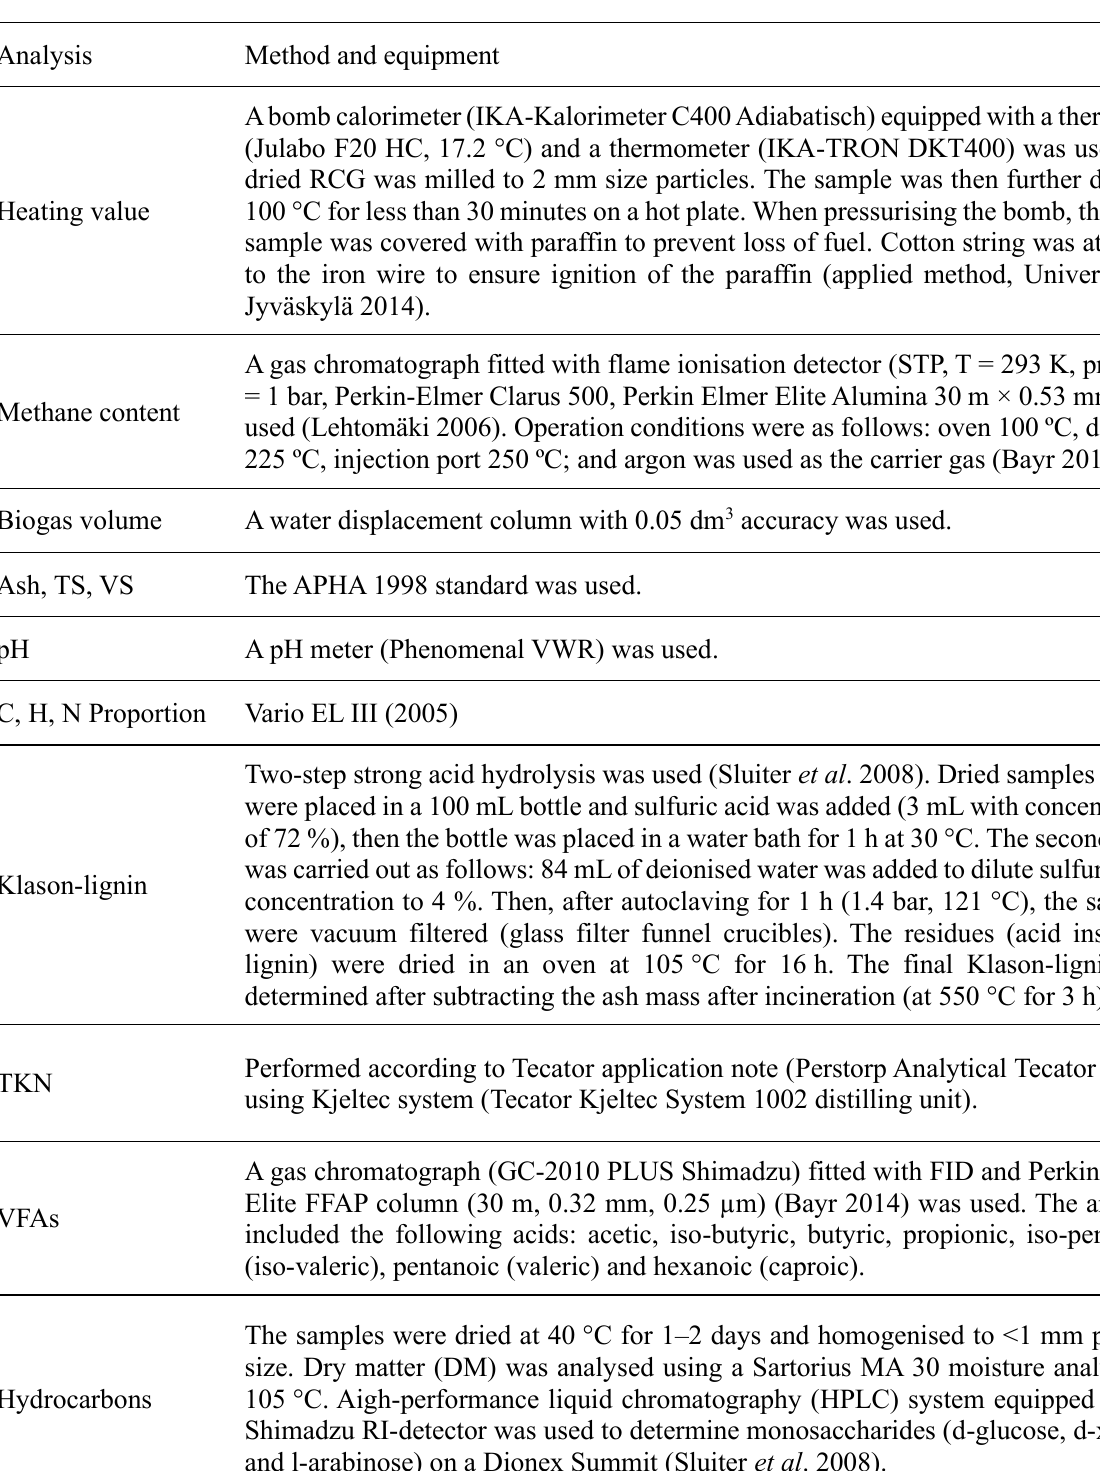
Table 2. List of analyses, methods and equipment used in the laboratory